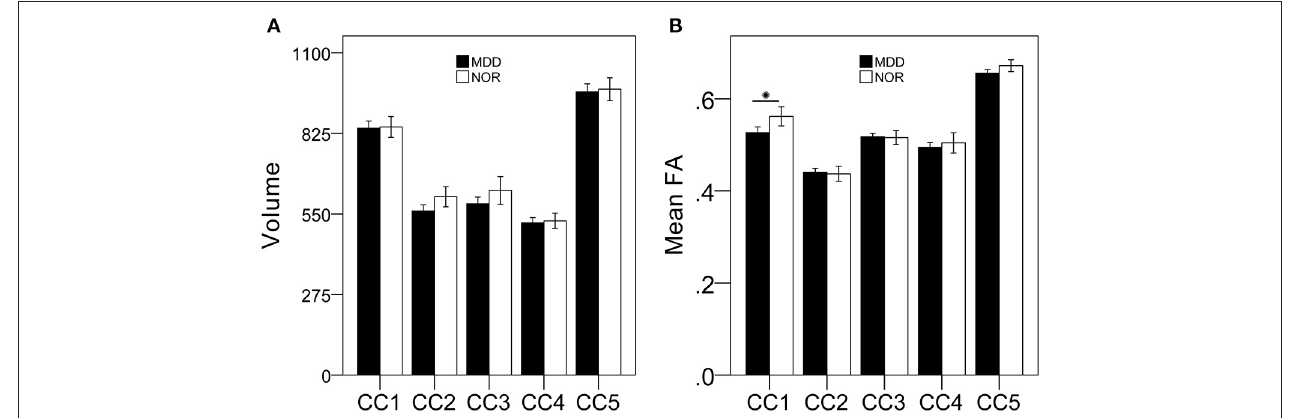
FIGURE 1 | MDD patients exhibit damaged anterior CC microstructural but not macrostructural integrity compared with that of healthy controls. There were no significant differences in CC subregional volumes between MDD patients and healthy controls (A) ; MDD patients had lower FA of the anterior CC subregion compared to that of healthy controls (B) . * p < 0.05, bonferroni